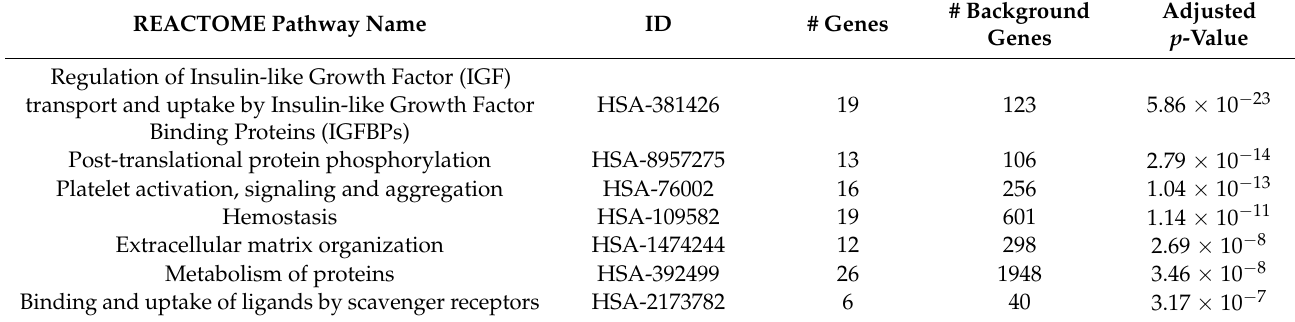
Table 2. REACTOME pathways affected by intervertebral disc herniation in canine cerebrospinal fluid (filtered list based on the relation to the disease). Complete list can be found in Supplementary File